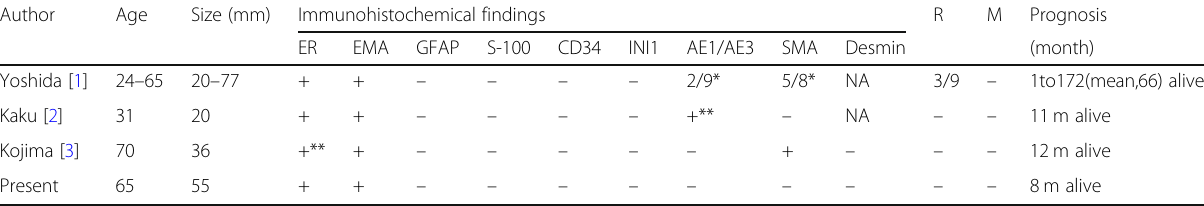
Table 2 Summary of clinical and immunohistochemical findings of previously reported and present cases of